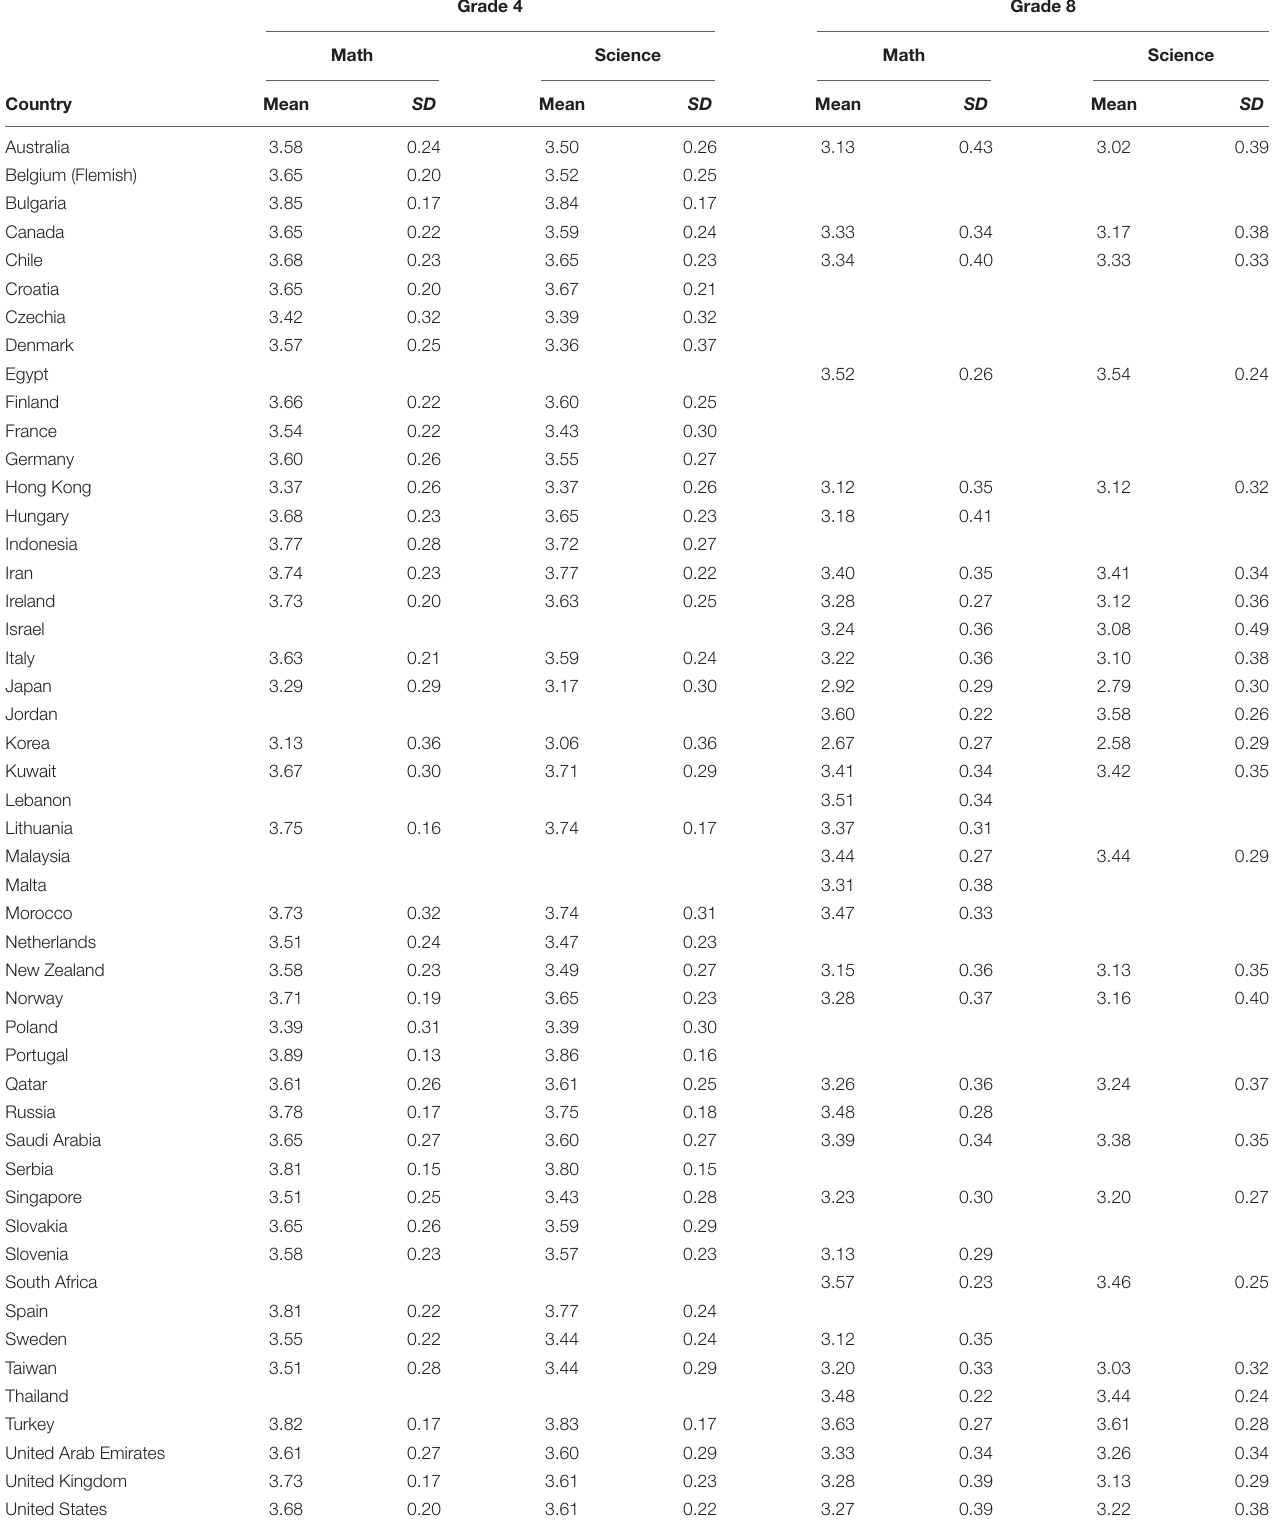
TABLE 2 | Descriptive Statistics of MBF